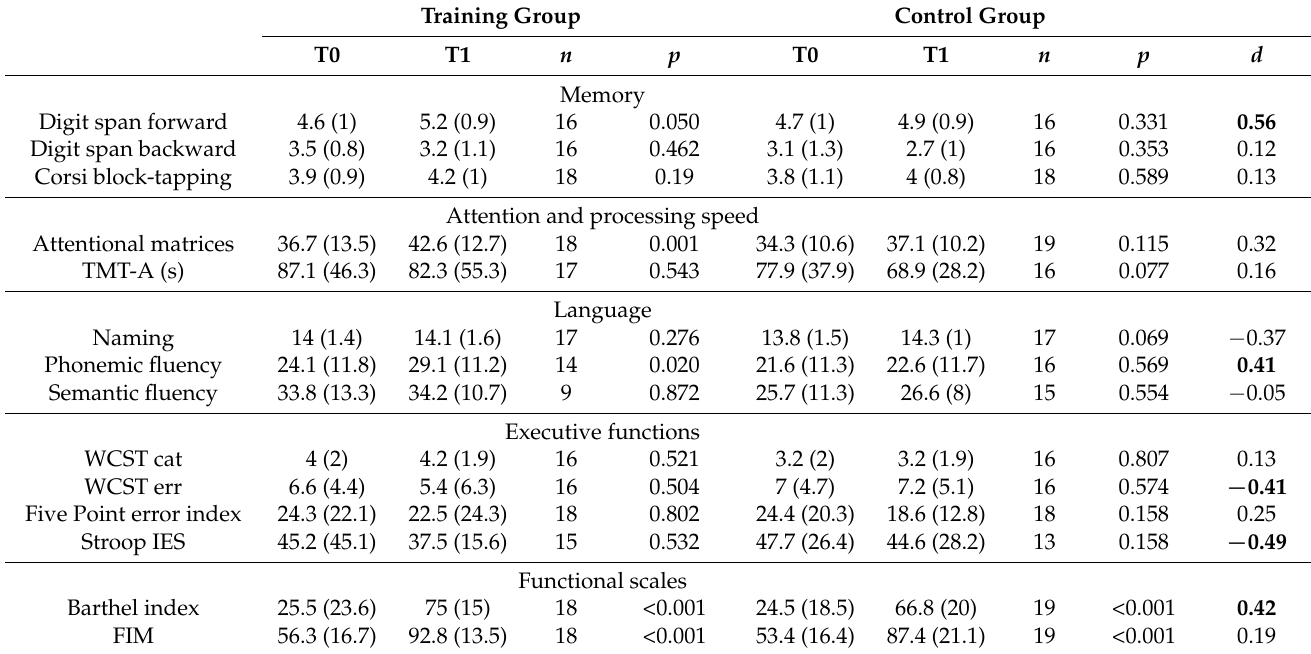
Table 2. Means and standard deviations (in parentheses) for Pre- (T0) and Post-rehabilitation (T1) sessions. P -values derived from Wilcoxon signed-rank tests for not normally distributed variables (Digit span forward, Digit span backward, Corsi block-tapping test, Naming, Wisconsin Card Sorting Test WCST categories and errors, Stroop Inverse Efficiency Score, and Functional Independence Measure), and from paired t -tests for normally distributed variables (Trail Making Test-A, Attentional matrices, Phonemic fluency, Semantic fluency, Five Point error index, and Barthel index). The pre-test–post-test control group effect sizes were computed by the Morris’s formula [53]. In bold p -values < 0.050 and effect sizes > 0.4. N varies across tests because some participants could not perform all tests due to aphasia or